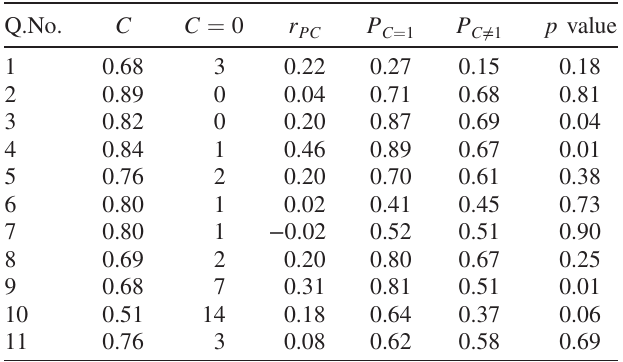
TABLE VIII. KiRC inventory confidence statistics: